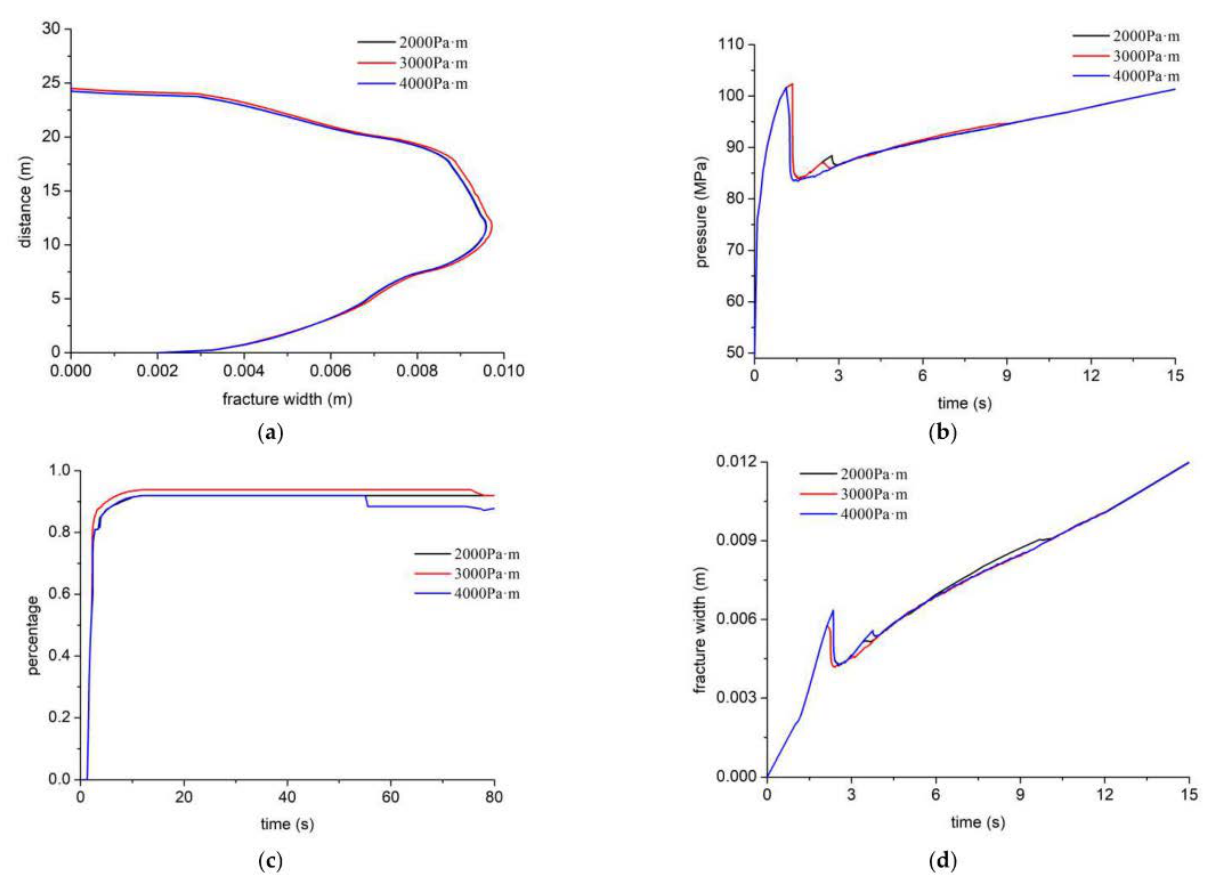
Figure 21. Fracture parameters under different fracture energy levels: ( a ) HF width; ( b ) pressure; ( c ) ratio of tensile failure; and ( d ) maximum HF